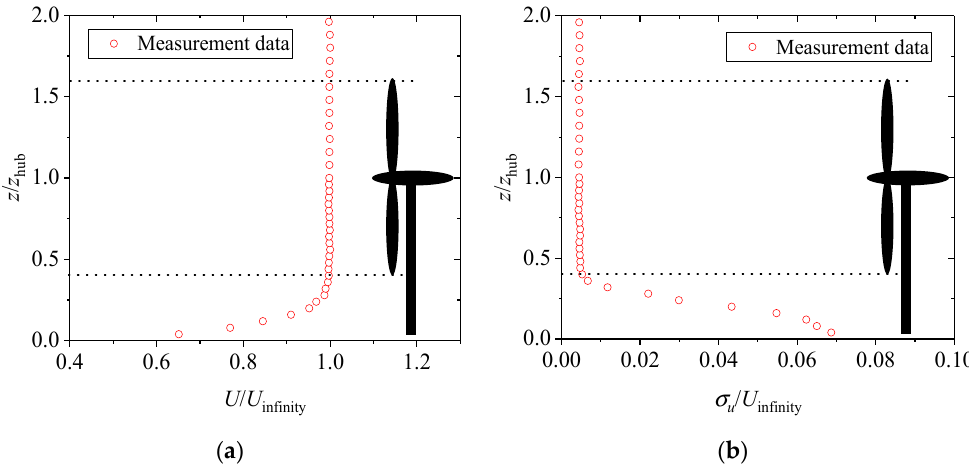
Figure 4. The measured profiles of the normalized inflow velocity and turbulence intensity. ( a ) Mean velocity; ( b ) turbulence intensity.